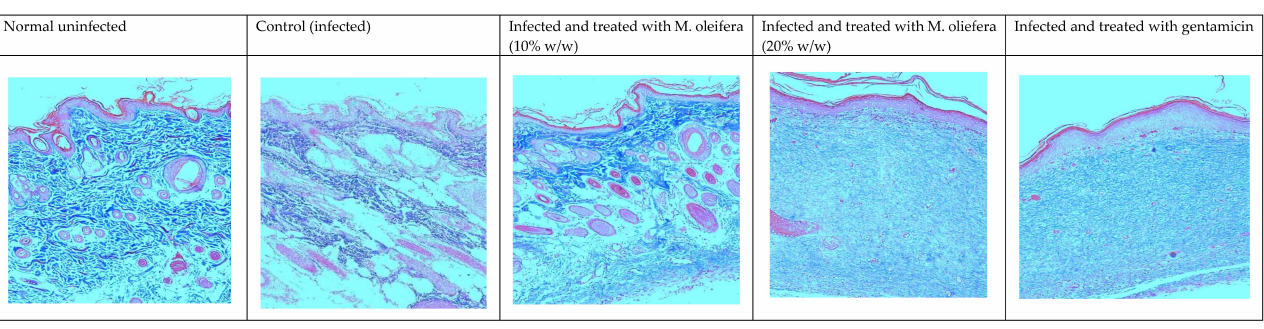
Figure 13. Skin histology of P. aureginosa -infected wound (stained with Masson’s trichrome stain) after different treatments. The blue color indicates